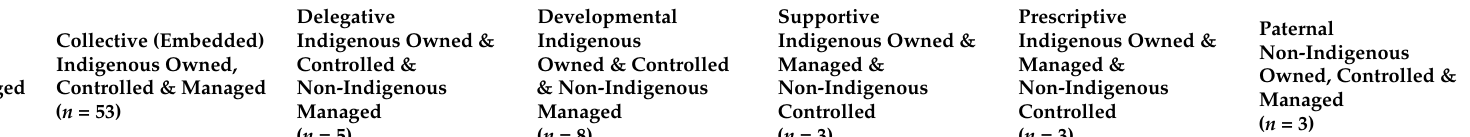
Table 4. Conceptual framework of Indigenous social enterprise (SE) and their relationship to key themes and cultural values identified in the literature ( n = 90) 1 .